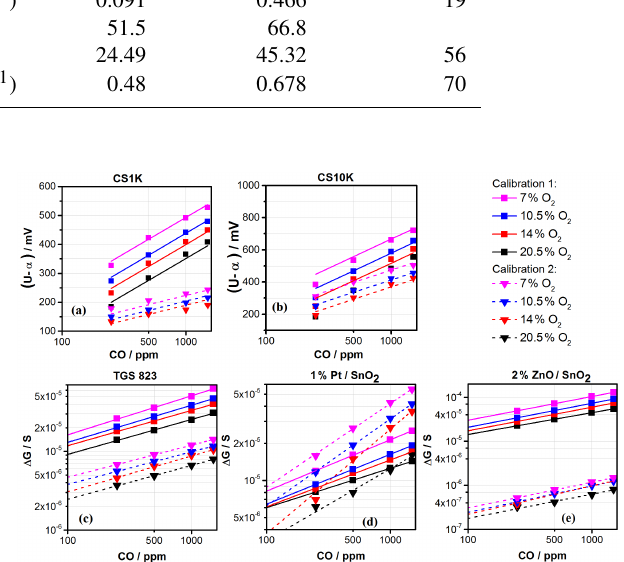
Figure 6. The responses of CS1K (a) , CS10K (b) , TGS823 (c) , 1% Pt/SnO 2 (d) and 2% ZnO/SnO 2 (e) to different CO and oxygen concentrations before (calibration 1) and after (calibration 2) the in situ operation in the firing